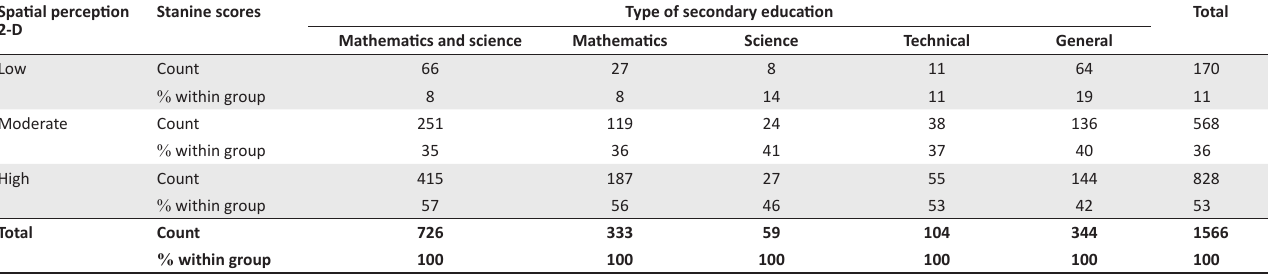
TABLE 5: Contingency table of observed frequencies for the spatial perception 2-D sub-test. Spatial perception 2-D